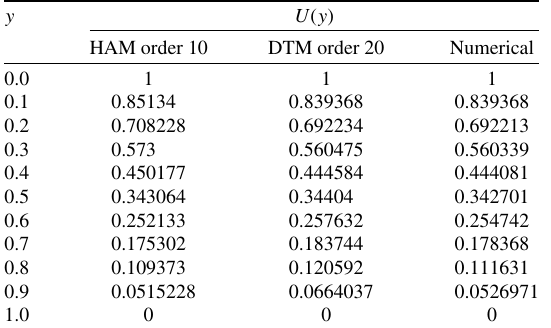
Table 4 Comparison of values of U ( y ) obtained by various orders of the HAM with numerical solution, when Re = 1 . 0 and Ha = 1 .